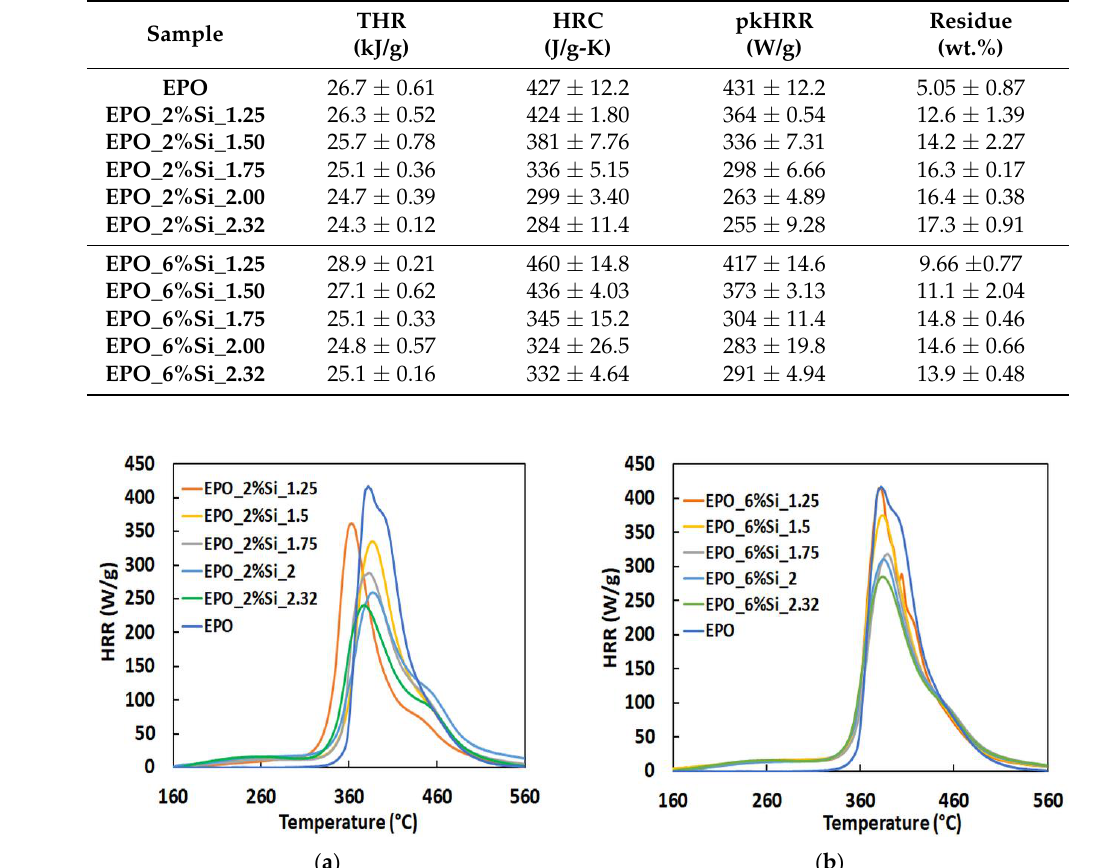
Table 5. PCFC data for epoxy samples containing 2 and 6 wt.% of silica.